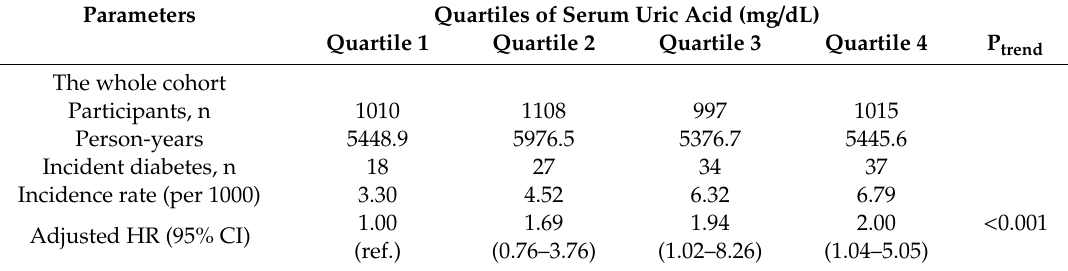
Table 2. The association between serum uric acid levels and the risk of type 2 diabetes.